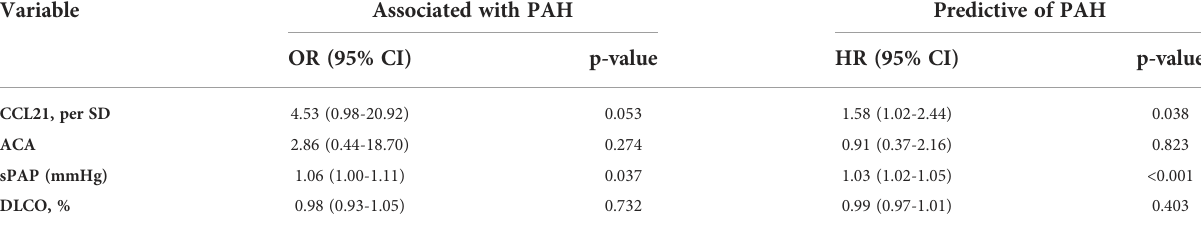
TABLE 3 Multivariable logistic and cox regression analysis showing CCL21 and other variables associated with PAH and predictive of PAH. Variable Associated with PAH Predictive of PAH OR (95% CI) p-value